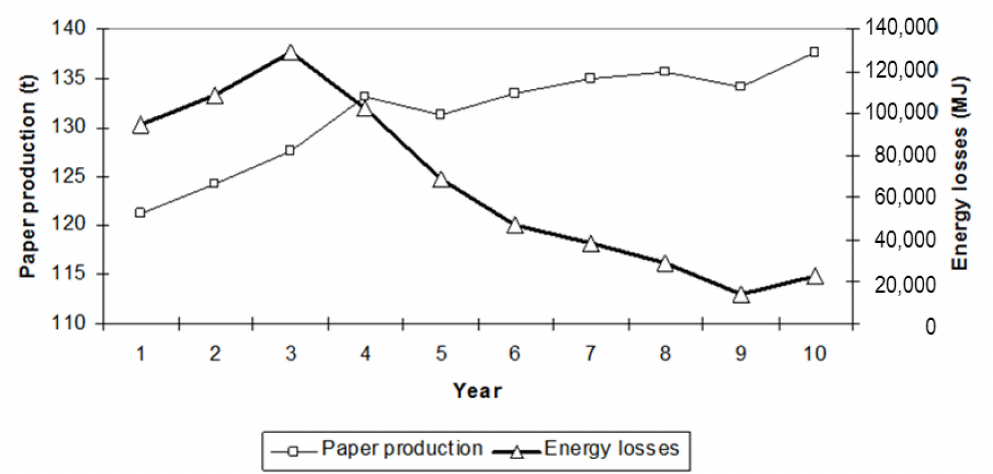
Figure 3. Daily and drying steam losses.